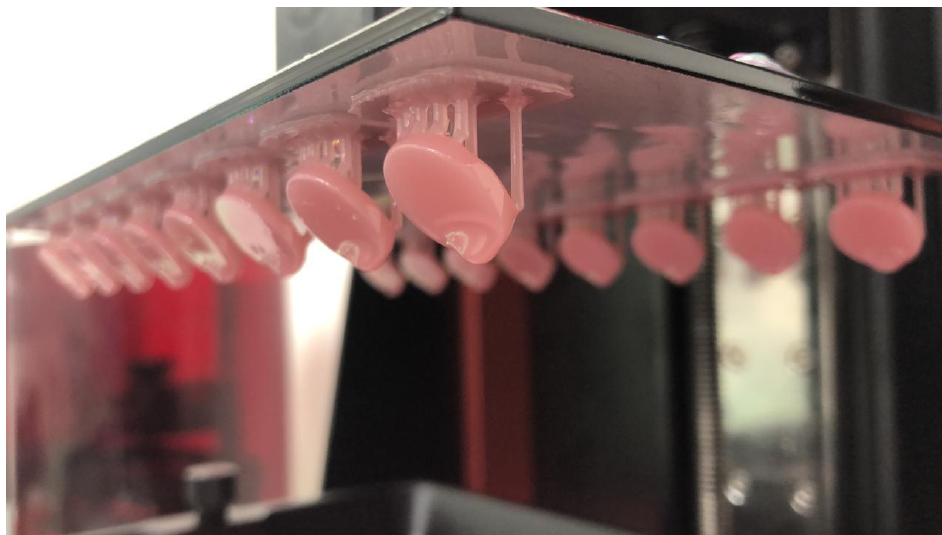
Figure 1. Specimens fabricated using 3D printing.